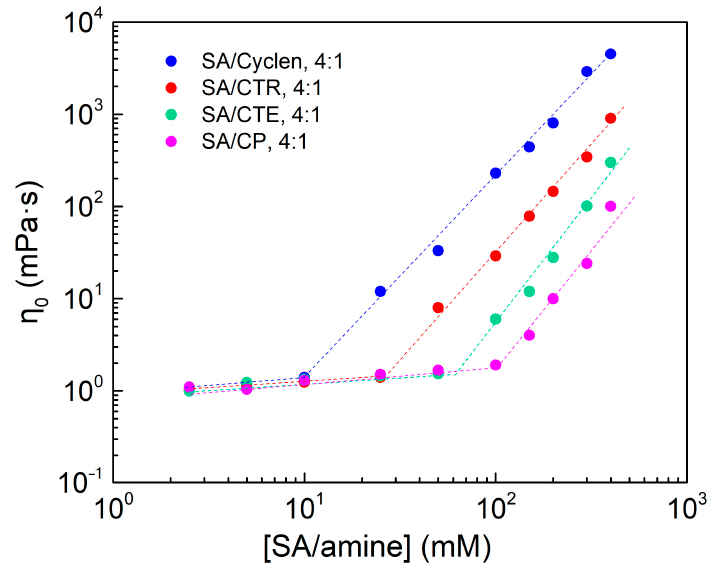
Figure 8. The effect of concentration on viscosity of SA/amine at 25 °C, the shear rate is 10 s − 1 .